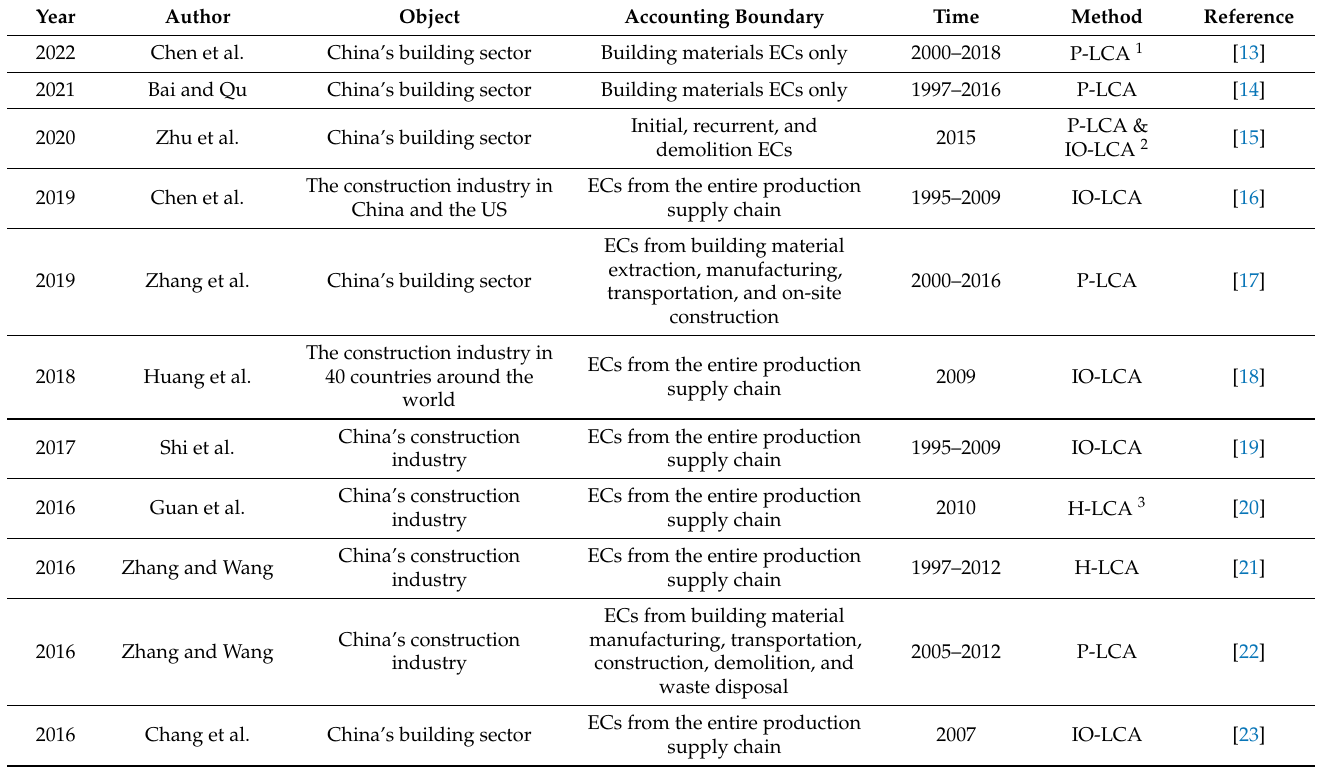
Table 1. Research on embodied carbon emissions at the macro